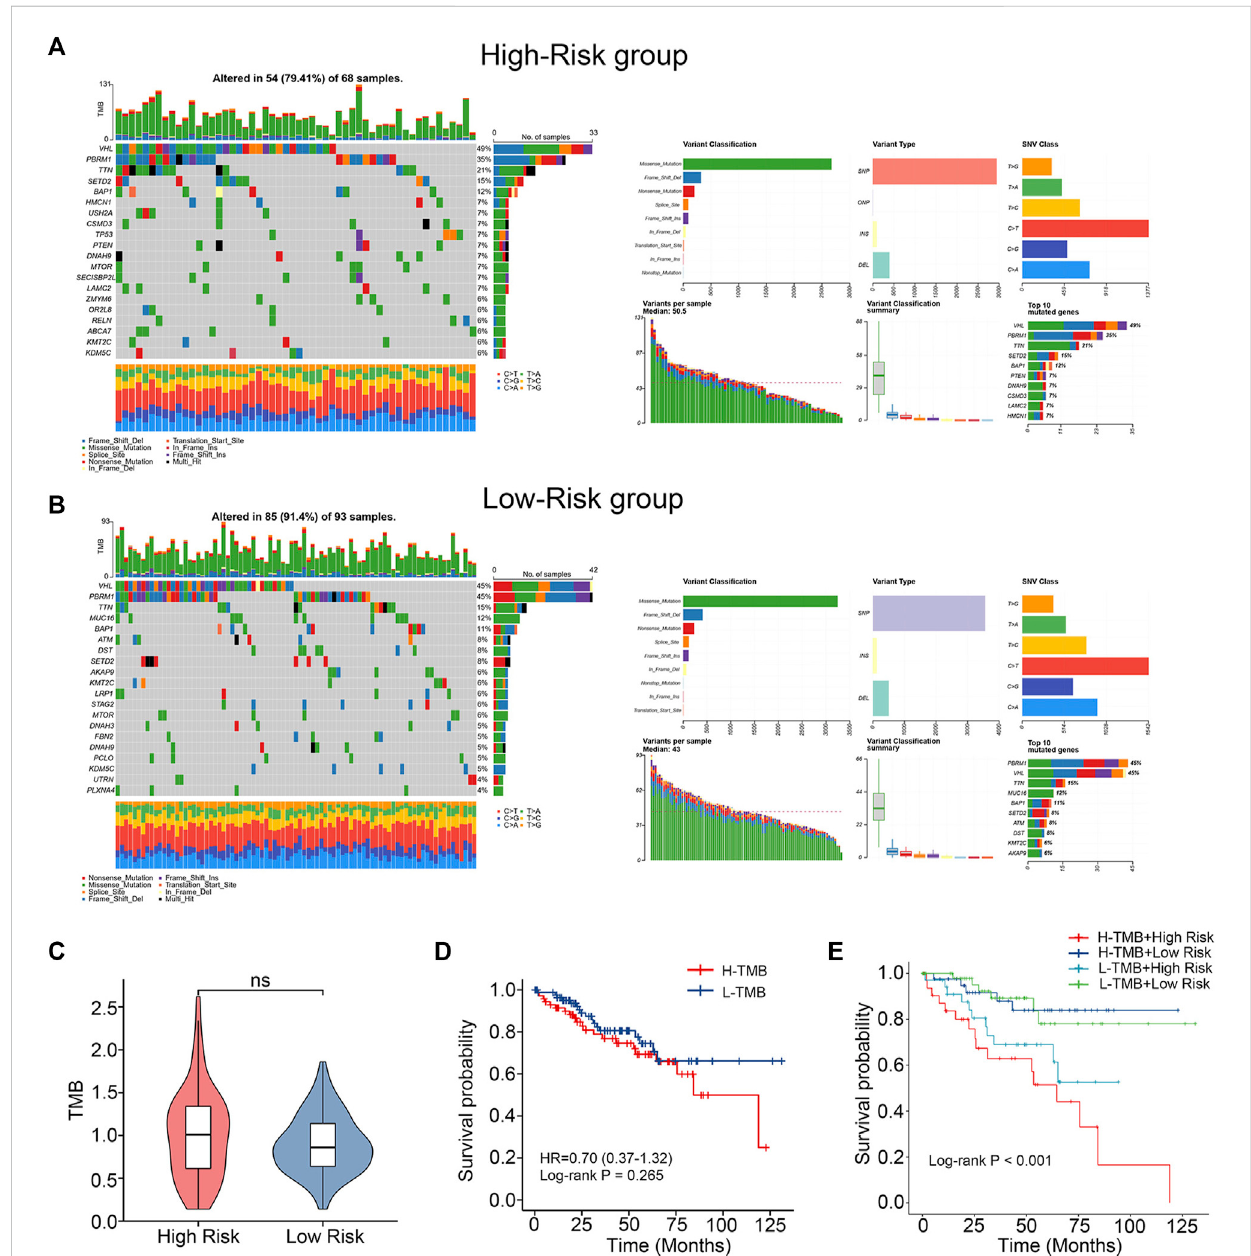
FIGURE 5 Differences in mutations between high- and low-risk groups. (A, B) Somatic mutation waterfall plots in the training cohort. (C) TMB difference between low-risk and high-risk group. (Wilcoxon test). (D) K-M survival curves comparing the groups with high and low TMB levels. (E) Intergroup K-M survival curves for the four